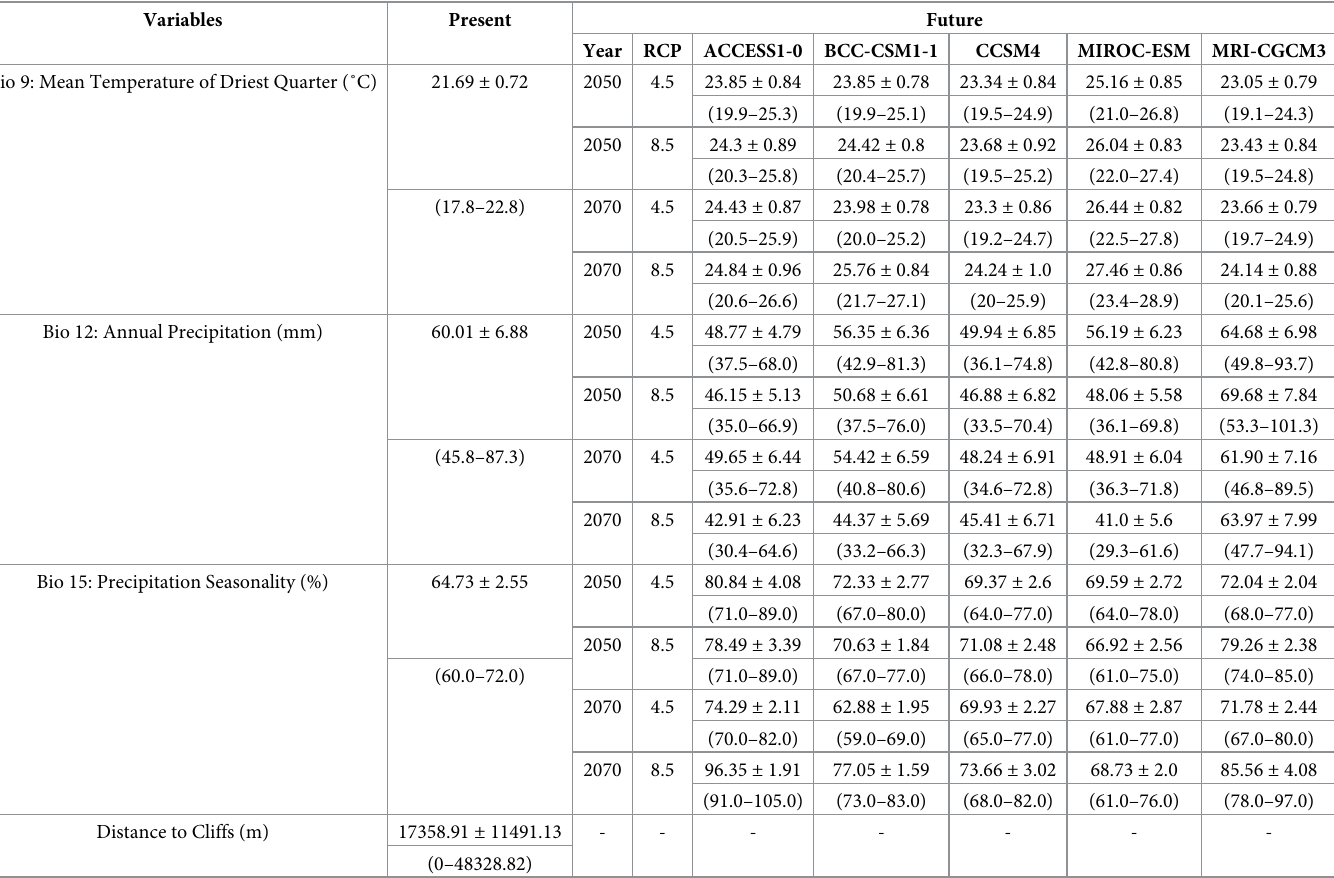
Table 1. Values of the selected environmental variables.